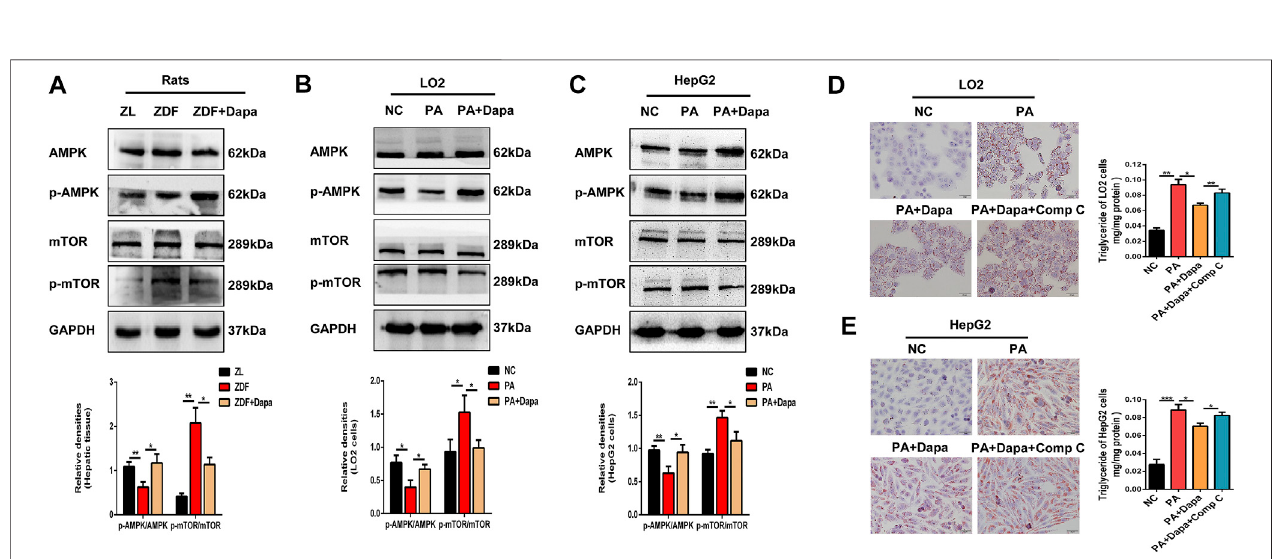
FIGURE5| Dapagli fl ozin induces autophagy viatheAMPK-mTORpathway invitro and invivo. (A – C) Westernblotanalysisevaluatedtheprotein expression levels of p-AMPK, AMPK, p-mTOR, and mTOR in rats and cells. (D, E) LO2 and HepG2 cells were treated with 0.3 mM PA, 20 μ M dapagli fl ozin and 10 µM compound C (Comp C) for 24 h. The cells were stained with Oil Red O and intracellular TG was quantitatively analyzed. Scale bars: 20 μ m. Data are expressed as the means ± SEM from three independent experiments. * p < 0.05, ** p < 0.01, and *** p < 0.001.